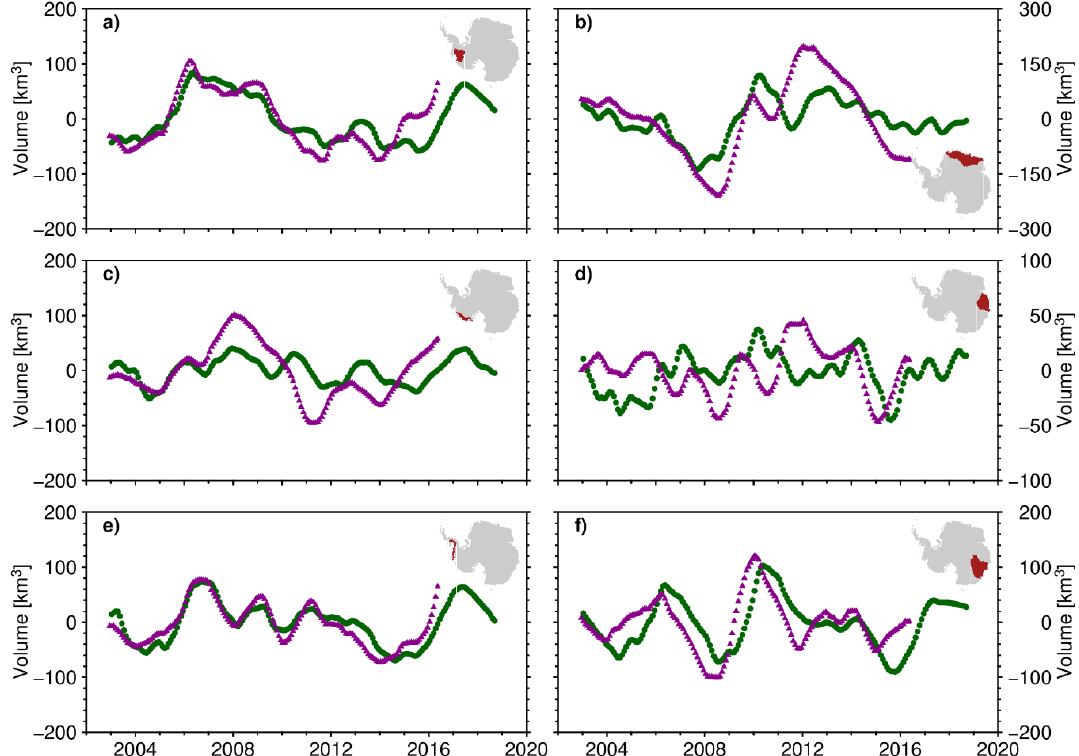
Figure 6. Volume changes of some subregions north of 81.5 ◦ S (Amundsen Sea sector ( a ), Dronning Maud Land ( b ), Getz sector ( c ), Princess Elizabeth Land ( d ), Bellingshausen Sea sector ( e ), and Totten Glacier sector ( f )) from our combined altimetric time series (green dots) and IMAU-FDM (purple triangles). After removing the long-term trends, seasonal oscillations were removed using a 13-month moving average. Due to the defects of the moving average algorithm, the 6-month values at the beginning and end of the time series are not displayed. The regions covered by each localization are shaded red in the inset. The boundaries refer to the Antarctic drainage systems in